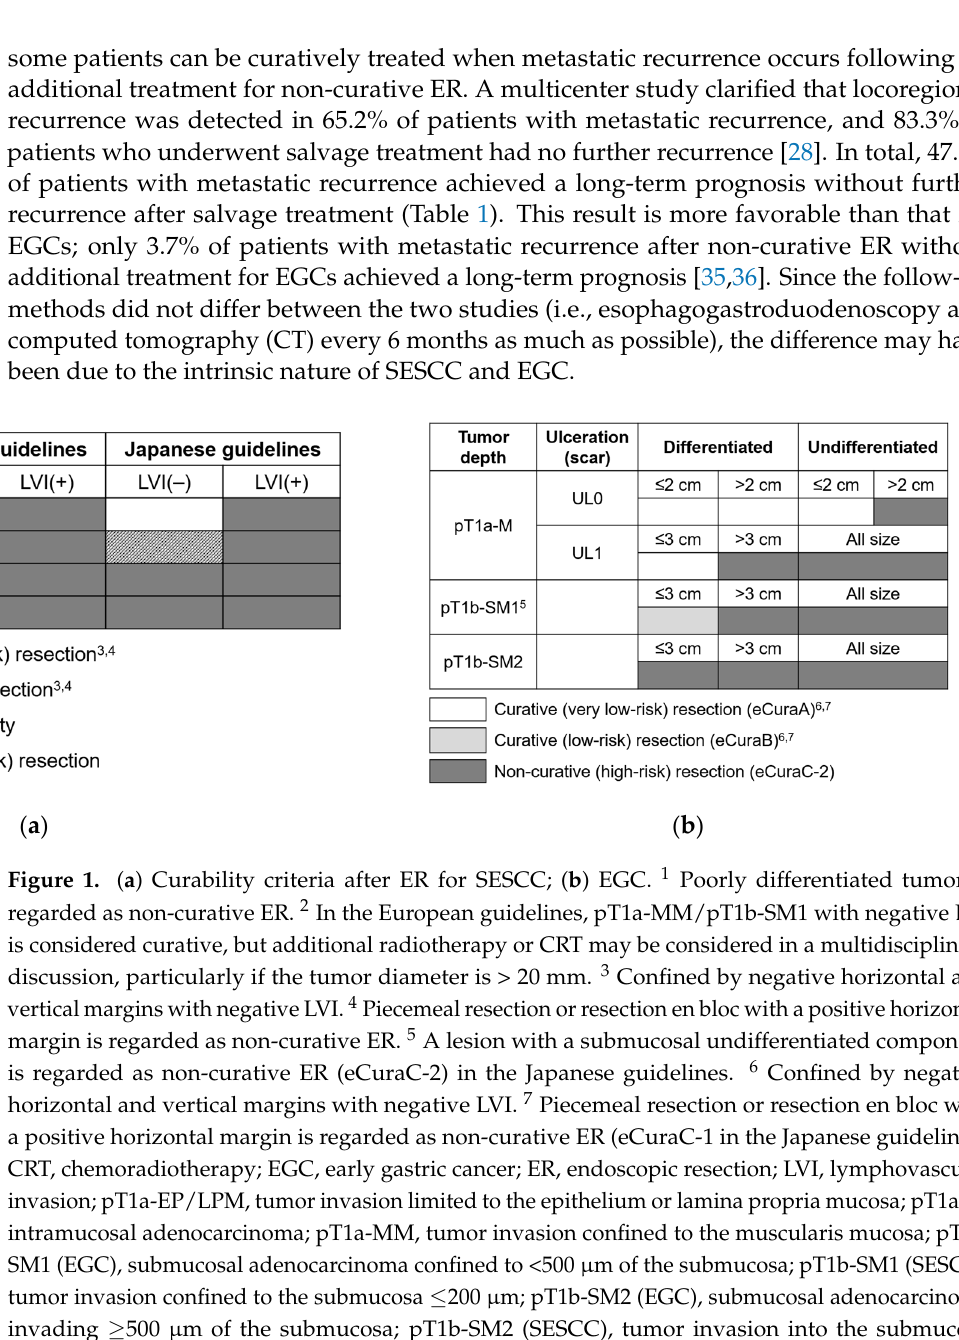
LVI; and high-risk, pT1b-SM with positive LVI (Figure 2a). The 5-year metastatic